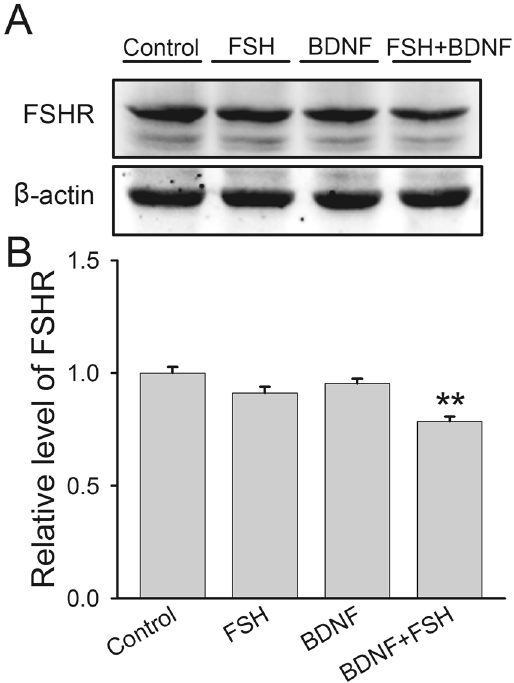
Figure 4. FSH receptor expression in treated KGN cells. KGN cells were treated with FSH (100 ng/ml), BDNF (5 ng/ml) and FSH (100 ng/ml) plus BDNF (5 ng/ml), respectively, for 24 h. ( A ) Western blot analysis of protein extracts from treated and untreated cells, showing FSHR protein level. ( B ) Quantitative analysis, with FSHR protein levels expressed as fold change over controls. Data are mean ± SD. ** P < 0.01 versus control